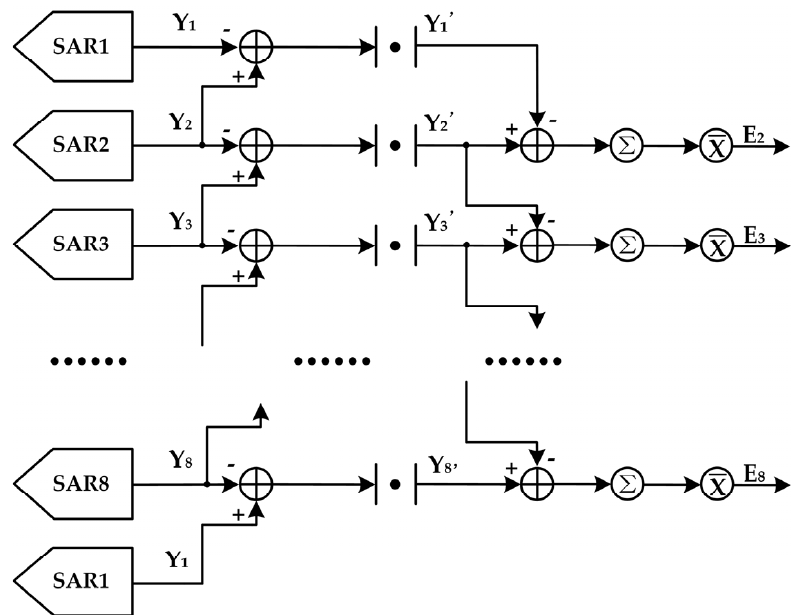
Figure 7. Coarse time-skew detector.